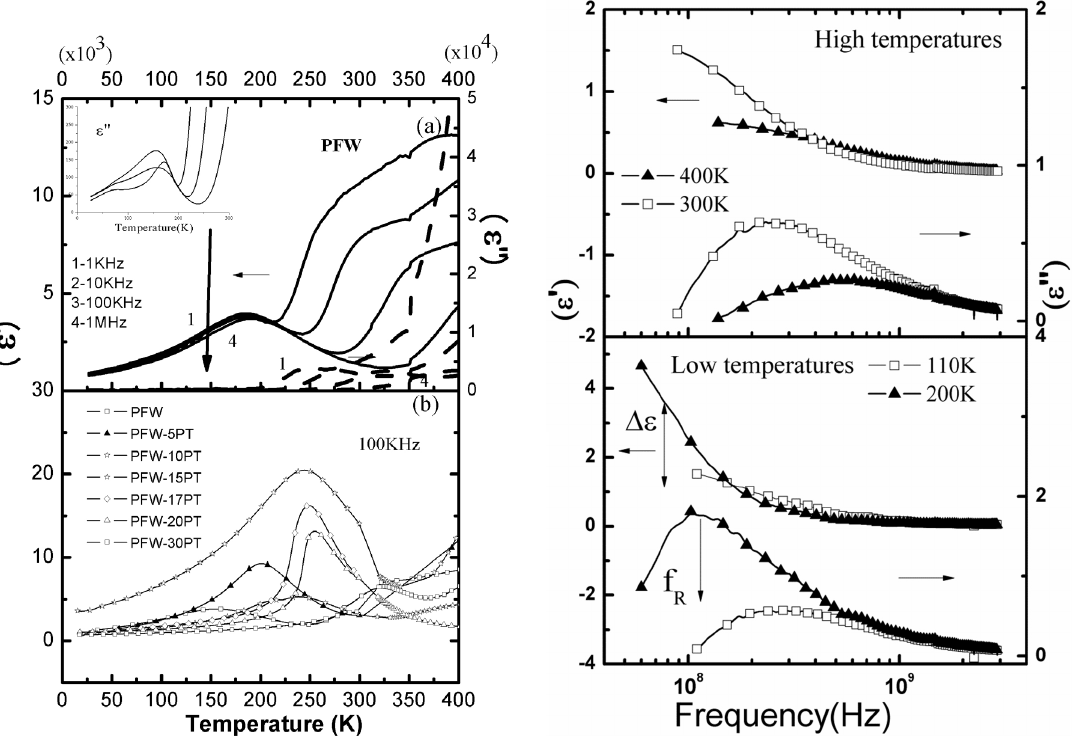
Figure 2. (a) Relative dielectric permittivity at various frequencies as a function of the temperature for PFW ceramic and at 100 kHz (b) for (1- x )Pb(Fe solutions ( x =0.1-0.30).